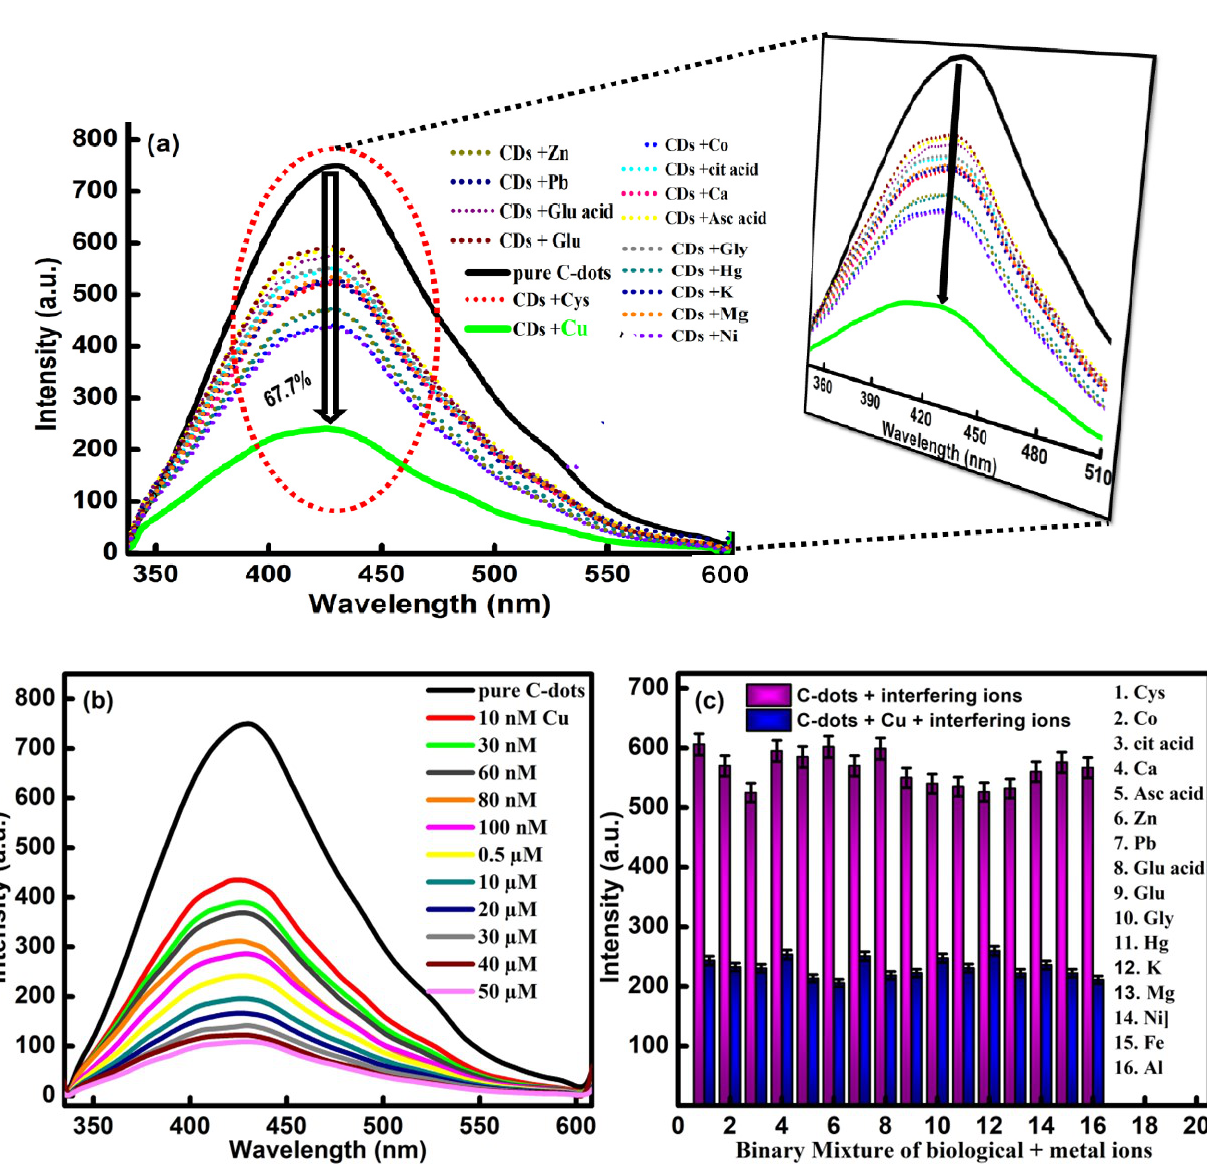
Figure 7. ( a ) Fluorescence emission spectra of CQDs in the presence of chosen metal ions and bio-molecules, ( b ) concentration variation of Cu 2+ and ( c ) interference study of Cu 2+ with several metal ions and biomolecules in the presence of CQDs.